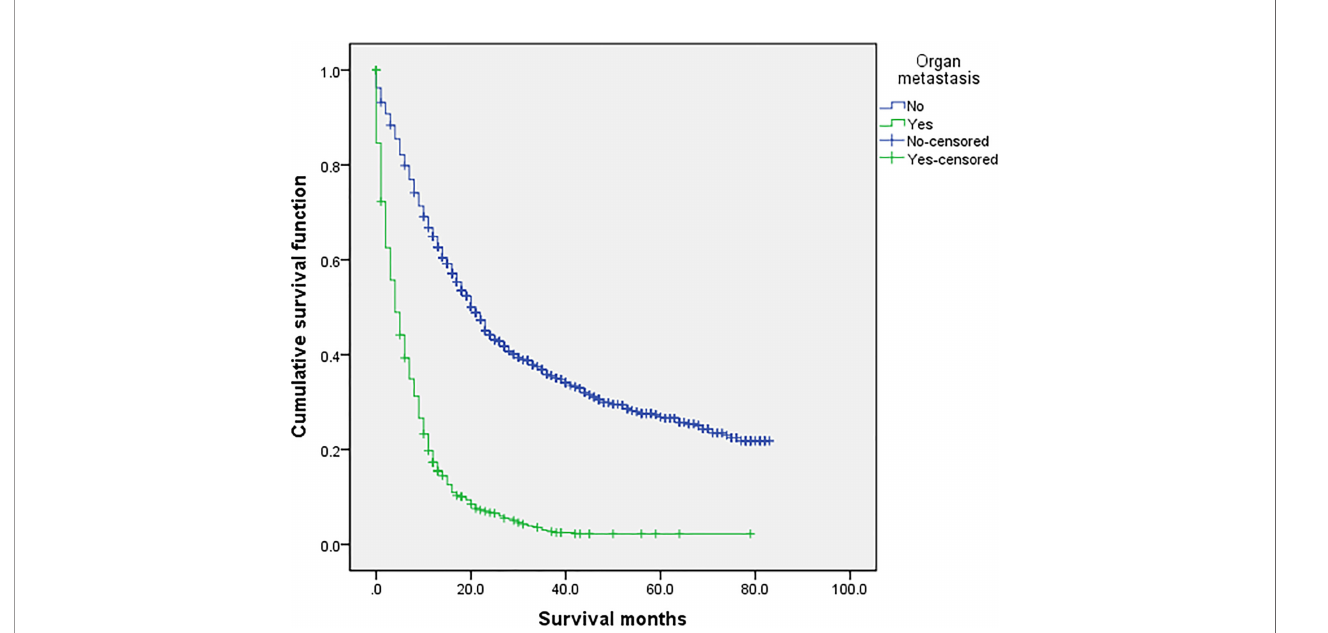
FIGURE 1 | Comparison of survival time between the two groups. In the overall sample (n = 2,072), univariate analysis of the no organ metastasis group and the organ metastasis group showed that P < 0.001 was obtained by Kaplan – Meier survival analysis log rank (mental Cox). There was signi fi cant difference between the two